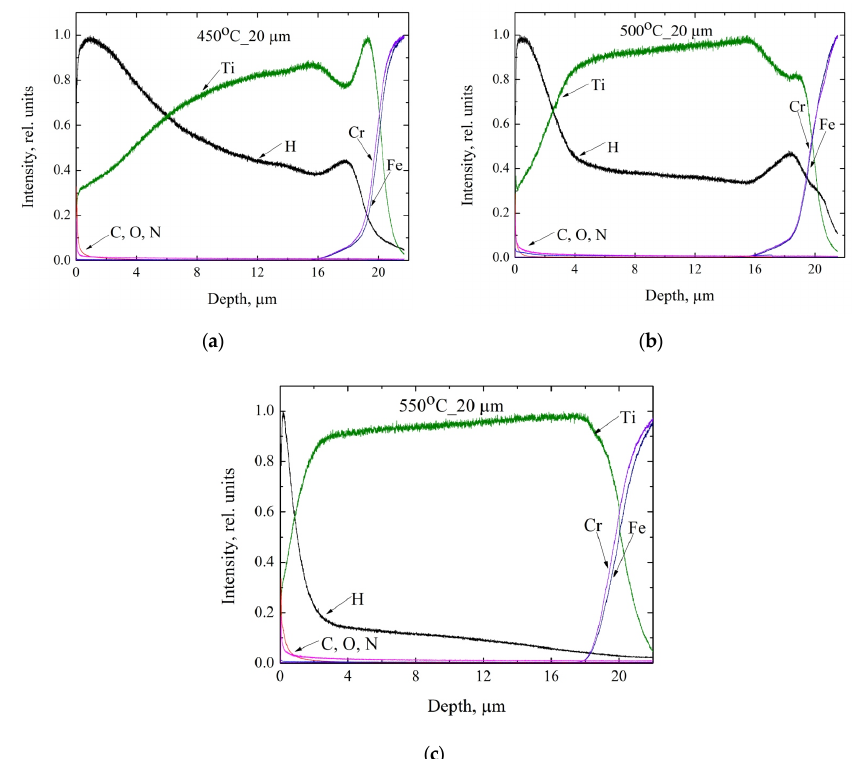
Figure 8. Distribution of elements in the 20 µm Ti coating during hydrogenation at different temperatures: 450 °C ( a ), 500 °C ( b ), and 550 °C ( c ).